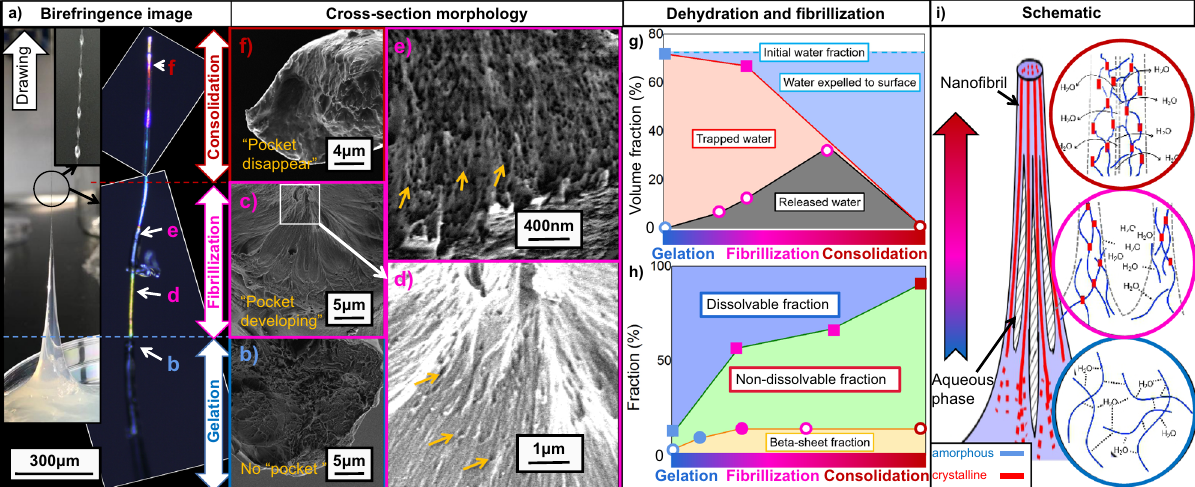
Fig. 2 The structural development in the formation of a silk fi bre is demonstrated in this fi gure. A drawn silk feedstock and subsequent imaging of the last few millimetres under cross-polars ( a ), note the gradual increase in birefringence as structure develops. Inset: the water droplets expelled to the fi bre surface as it solidi fi es. SEM images of fractured cross-sections of each segment b – f of the drawn fi bre are shown in the image ( b – f ), c the inset region indicated by the white box is magni fi ed and contrast-enhanced to show the development of water pockets (yellow arrows), which become more common as nano fi brils are assembled ( e ), eventually leaving only the ~30 nm diameter ‘ needle-like ’ structures are left solid besides water pockets, f these pockets subsequently disappear and needle-like structures fuse into a dense fi bre. Dehydration-related structural changes are presented in g where the grey region represents the volume fraction occupied by the water pockets, the red region represents residual water within protein domains (calculated by initial solution water fraction minus phase-separated and expelled water) and the blue region represents water expelled to the sample surface (measured by careful mass comparison before and after removal of surface water droplets). The corresponding increase of non-dissolvable protein is shown in h , where the yellow region represents the beta-sheet crystal fraction, the green region represents the non-dissolvable protein fraction and the blue region represents the dissolvable protein fraction. In g and h data points marked by hollow circles were derived from SEM images, data points shown as solid circles were obtained by Raman spectroscopy, and data shown as solid squares were calculated from measured mass differences. A schematic of the complete process is shown in i where blue chains represent amorphous fi broin and red blocks represent beta-sheet